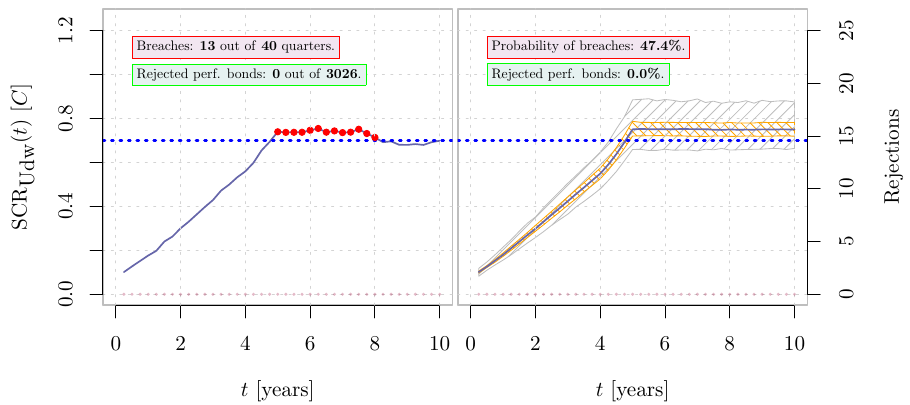
Figure 4. Dynamics of SCR Udw ( t ) . Left panel : example of Monte Carlo simulation (single scenario), where the horizontal dashed line represents the SCR Udw threshold that is fixed in the RAF, while red dots correspond to the simulated breaches of SCR Udw ( t ) above the SCR Udw level. Red columns at 0 level (right y-axis scale) represent the count of rejected performance bonds per quarter (zero since no management action is taken). Right panel : simulated distribution of SCR Udw ( t ) (10 3 Monte Carlo scenarios). The median (solid line), 0.25–0.75 quantiles (orange area), and 0.01–0.99 quantiles (grey area) are plotted. Red columns at 0 level (right y-axis scale) represent the average number of rejected performance bonds per quarter.